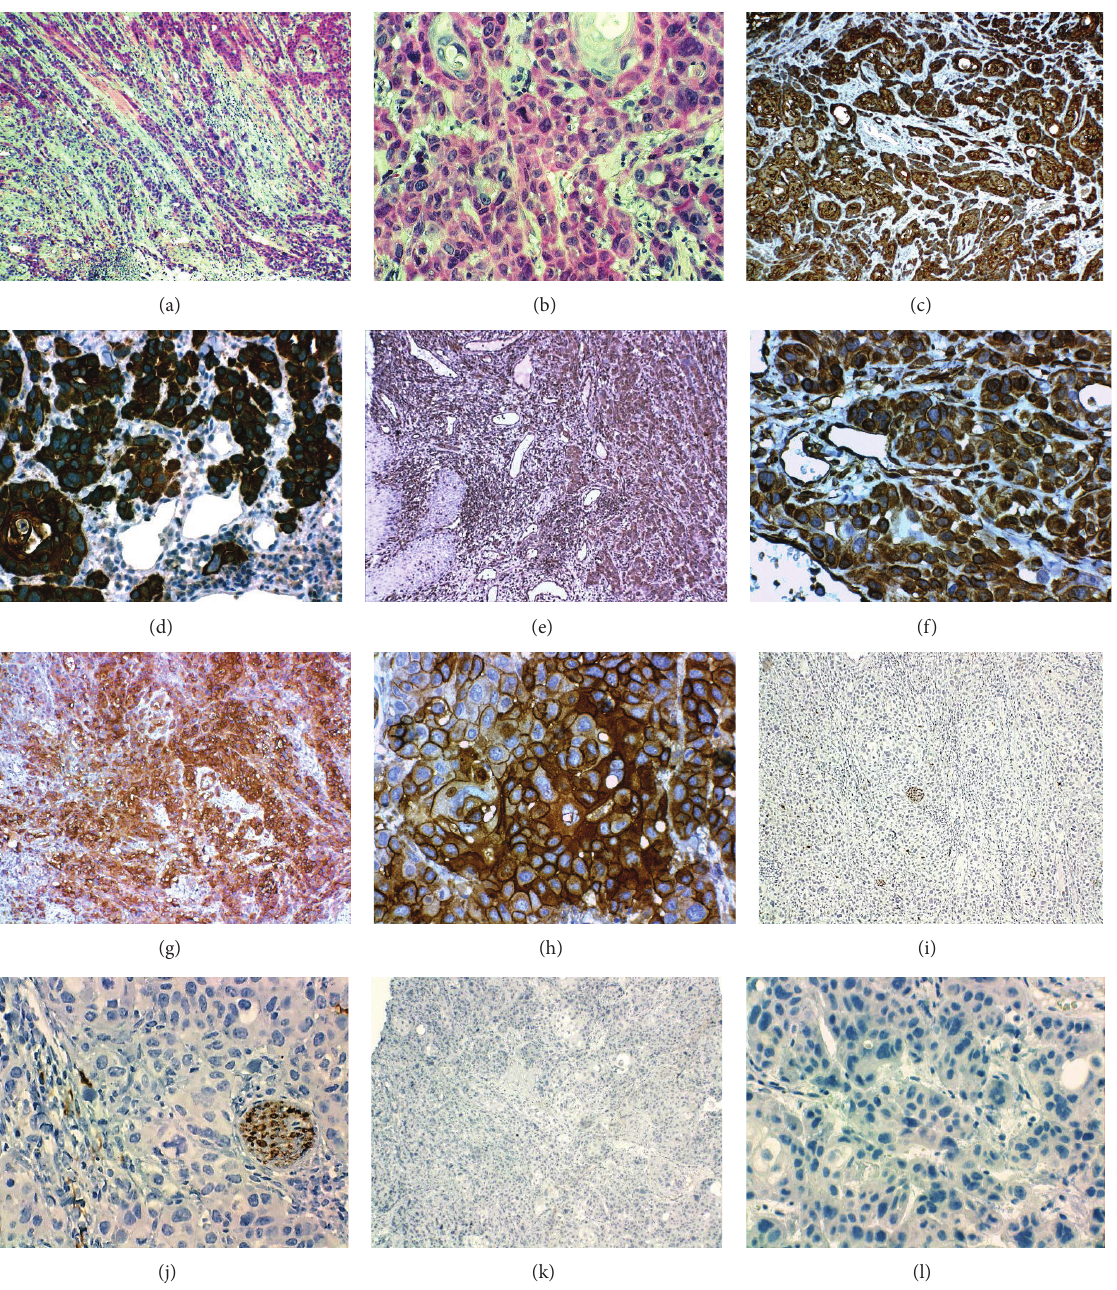
Figure 3: Case one: histopathology of the lesion. (a-b) Hematoxylin-eosin staining. IHC for cytoqueratin AE1/AE3 (c-d); staining of all cells that comprise the neoplasm is shown, as with vimentin (e-f). Expression for EMA (g-h) in epithelial cells. No expression was observed in the neoplastic cells for S-100 (i-j) or smooth muscle actin alpha